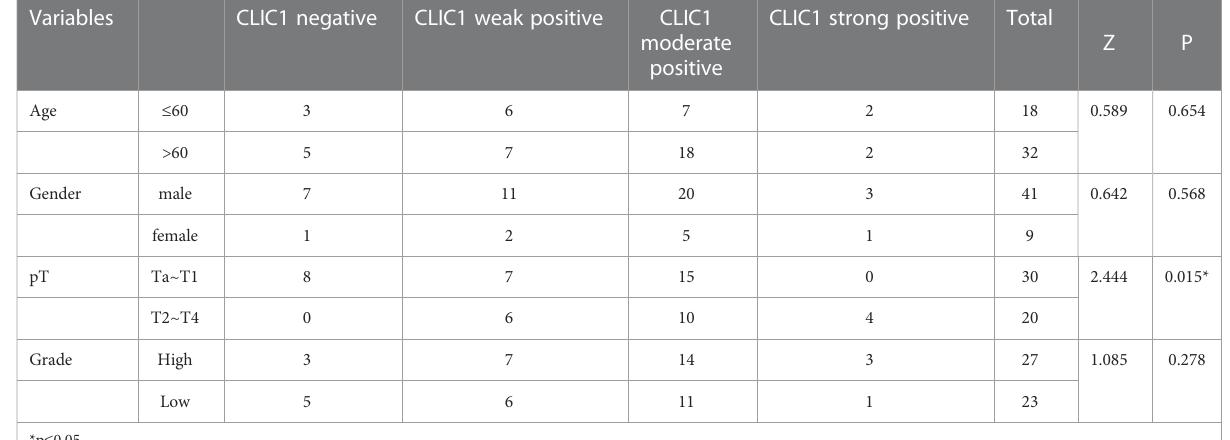
TABLE 1 Relationship between CLIC1 and clinical pathological characteristics in 50 patients with BC.